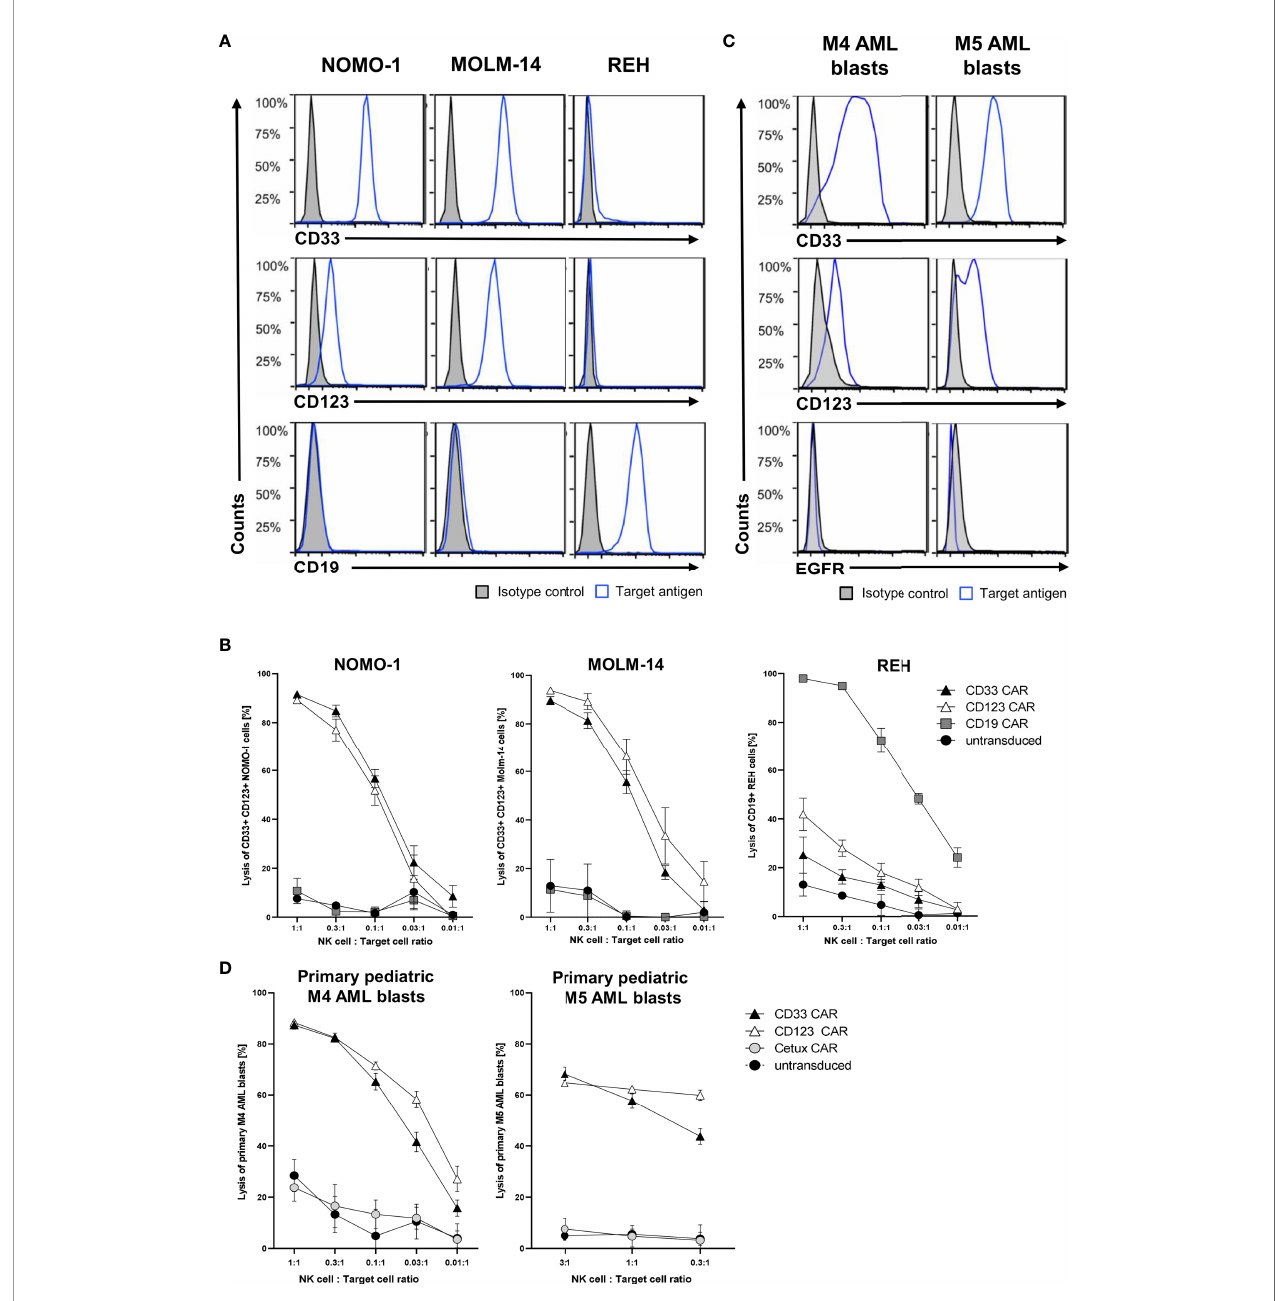
FIGURE 4 | Cytotoxic activity of CAR NK cells against leukemic cells. (A) AML cells NOMO-1 and MOLM-14, and ALL cells REH were analyzed for their surface expression of CD19, CD33, and CD123. (C) Primary pediatric M4 and M5 AML blasts were analyzed for their surface expression of CD33, CD123, and EGFR using conjugated antibodies by fl ow cytometry. CAR-transduced and microbead-enriched primary human NK cells were blocked as described previously and co-cultured with NOMO-1, MOLM-14, andREH cells (B) orprimary pediatric M4and M5AMLblasts (D) at various effector-to-target cell ratios to determine the speci fi c cytotoxic activity of CAR NK cells. The graphsrepresent mean ± SEM ofatleast fi ve (cell lines) or three(AMLblasts) biological